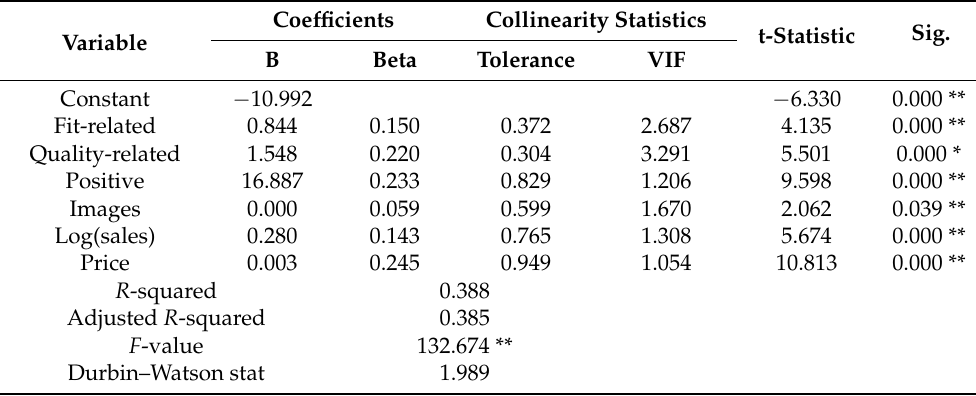
Table 4. Regression Analysis Results (N =